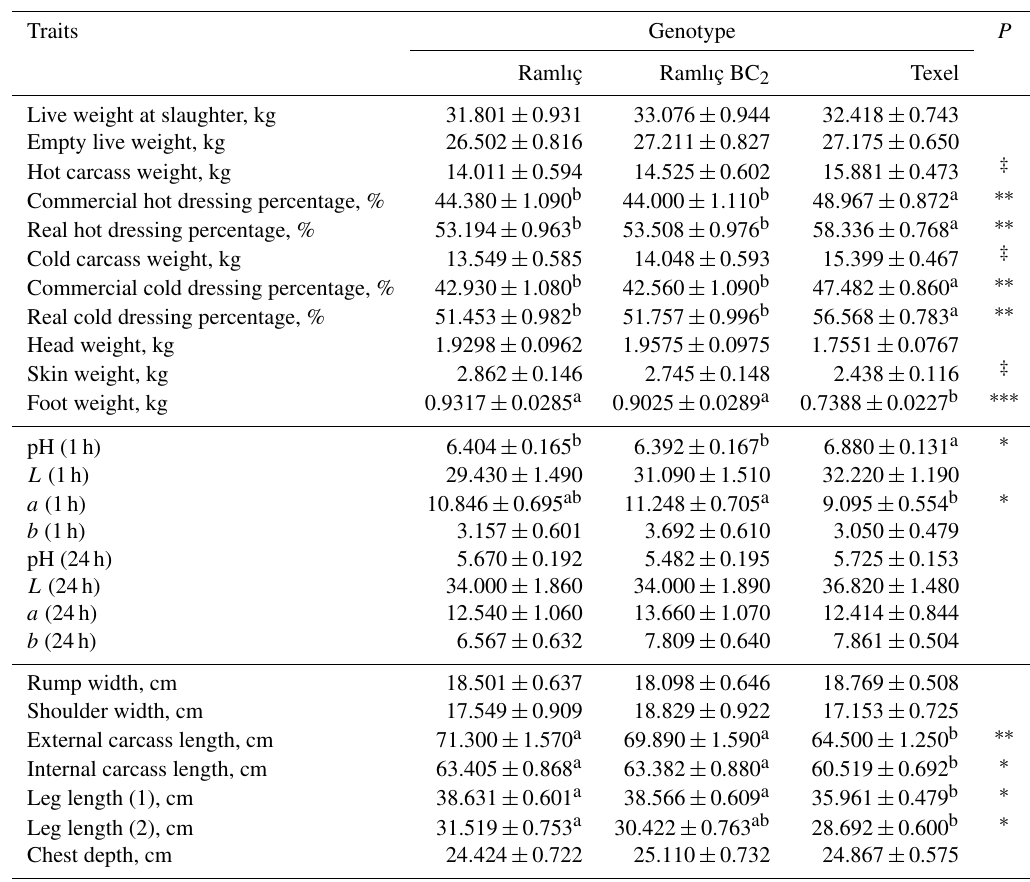
Table 2. Least-squares means and standard errors for post-slaughter carcass characteristics, pH and color parameters and carcass measure- ments of Ramlıç, BC 2 ( + / − ) and Texel